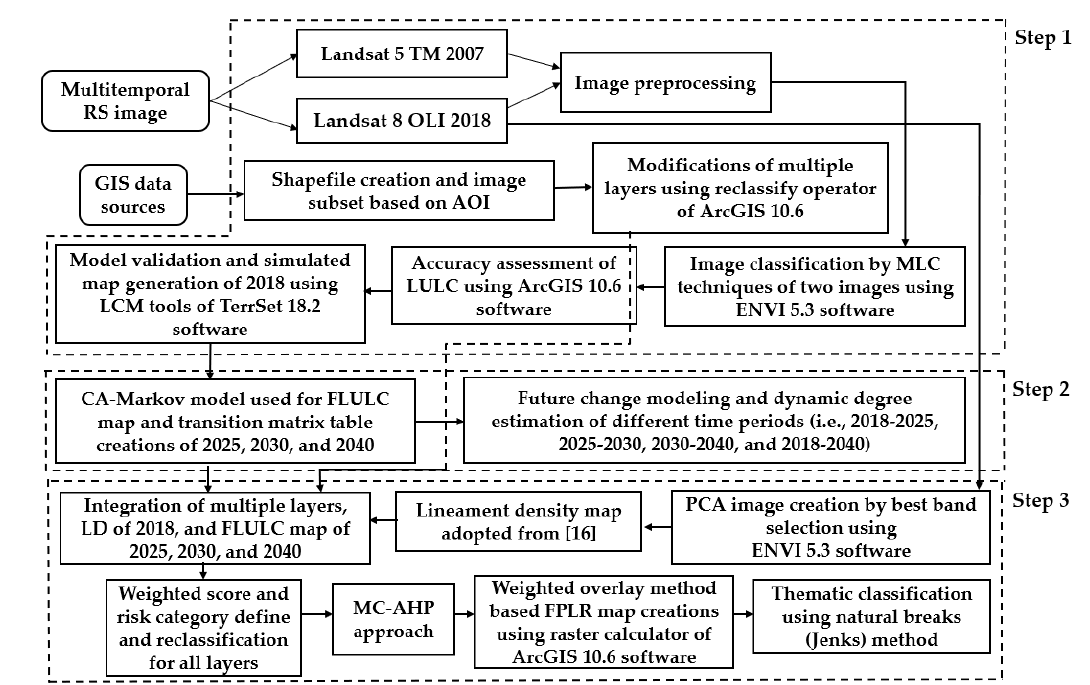
Figure 3. A research flowchart model used in this study. Note: RS, remote sensing; TM, thematic mapper; OLI, operation land imager; AOI, area of interest; GIS, geographical information system; LCM, land change modeler; FLULC, future land use and land cover; MLC, maximum likelihood classifier; CA-Markov, cellular automata–Markov; LD, lineament density; PCA, principal component analysis; MC-AHP, multicriteria based analytical hierarchy process; FPLR, future potential landscape risk.